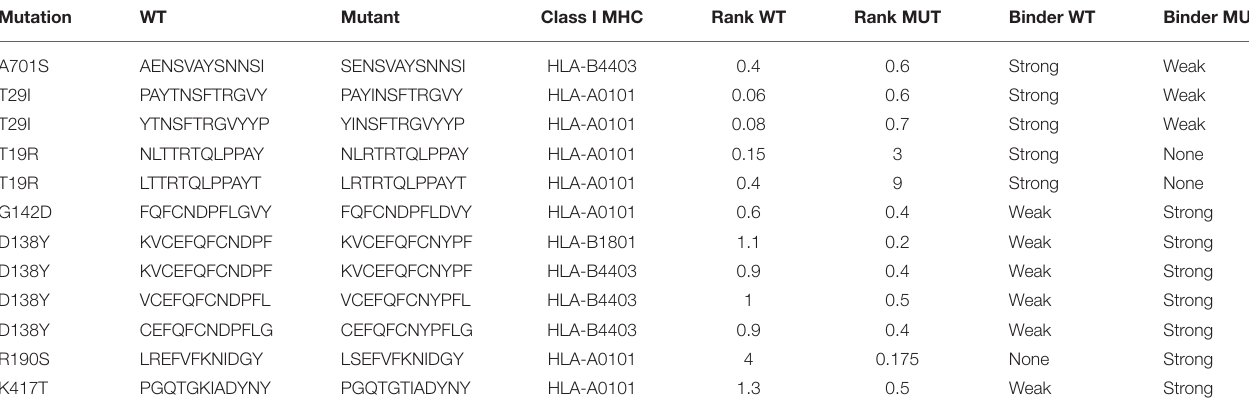
TABLE 3 | Binding affinity of peptides to class I MHC.